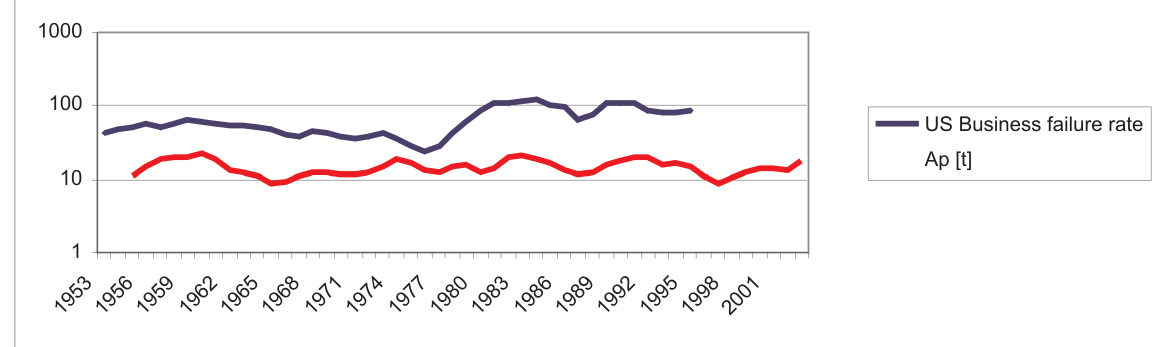
Fig 1. Yearly time series: US Business Failures Rate (source: Dun & Bradstreet, D&B) and moving average geomagnetic activity index Ap [t]